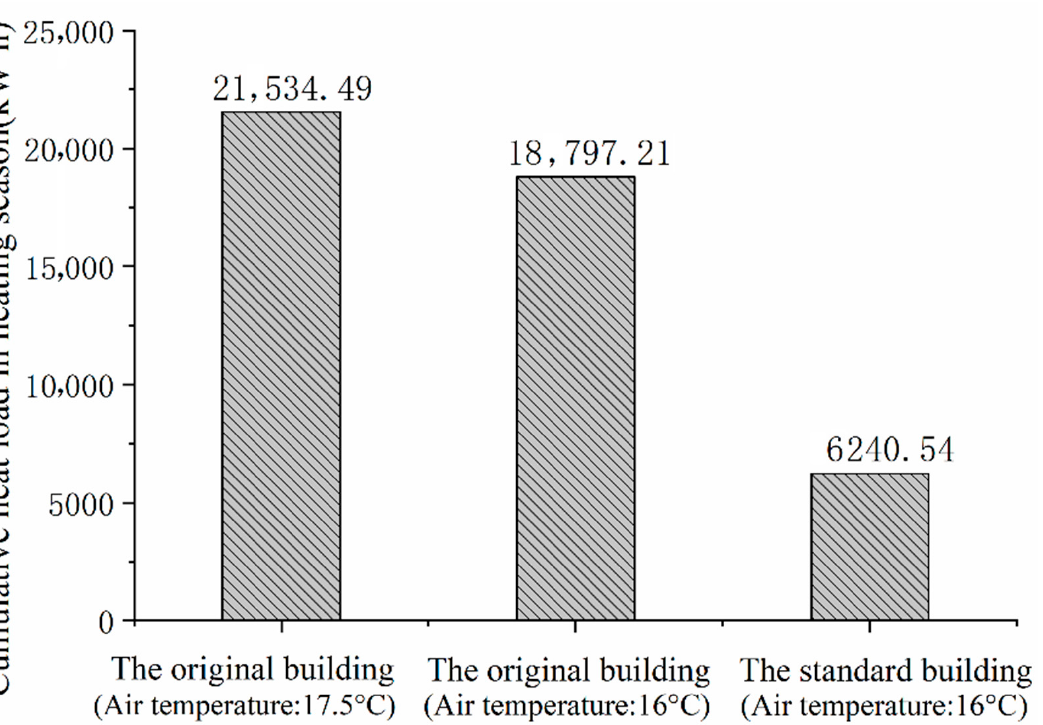
Figure 7. Cumulative heat load in heating season.